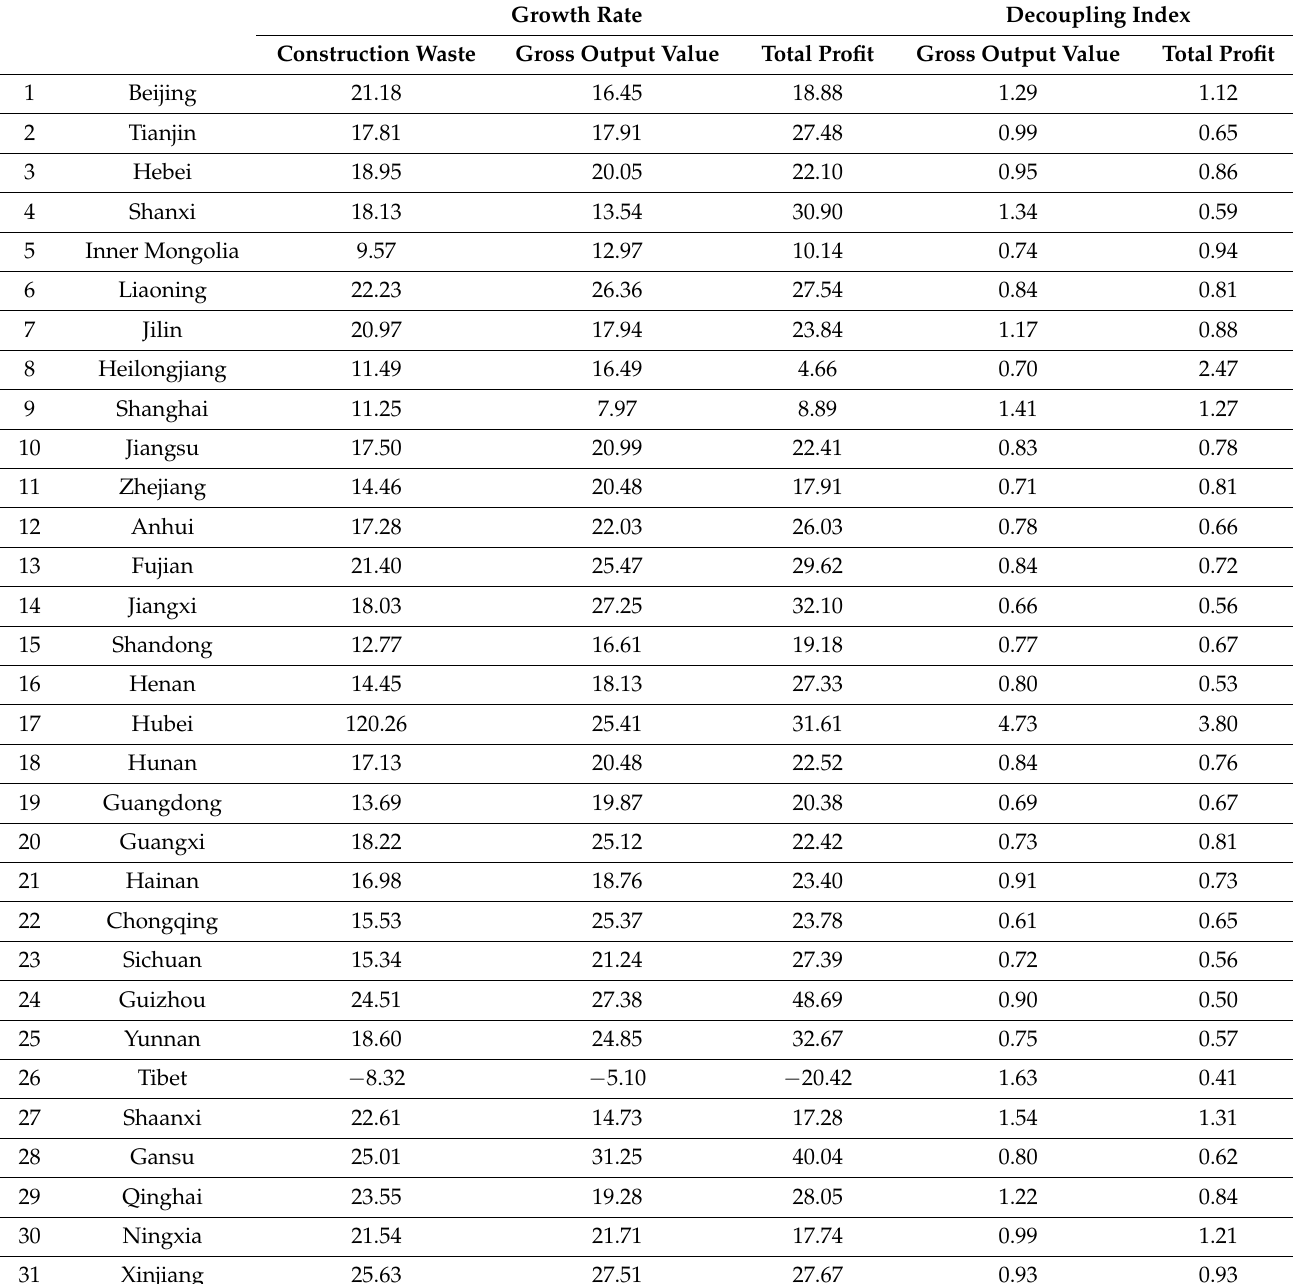
Table A1. Growth rate and decoupling index of construction waste and economy from 2009 to